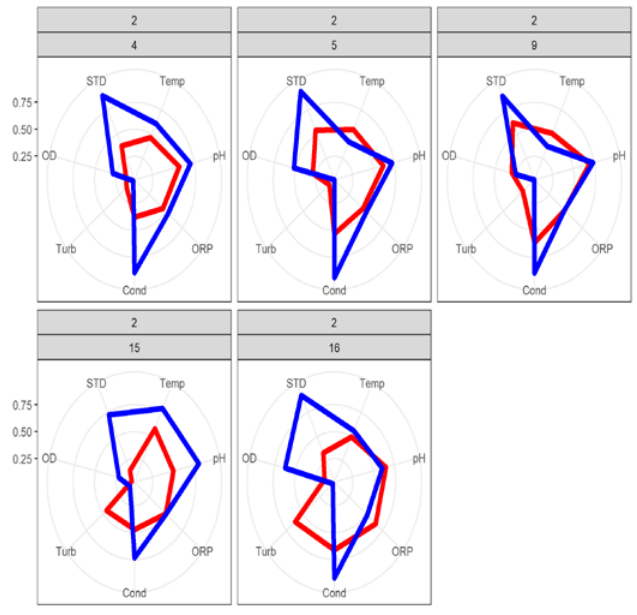
Figure 8. Correlation of water quality parameters during wet and dry seasons in a hydrological compartment (HC) 2. Red line (dry season), blue line (wet season).